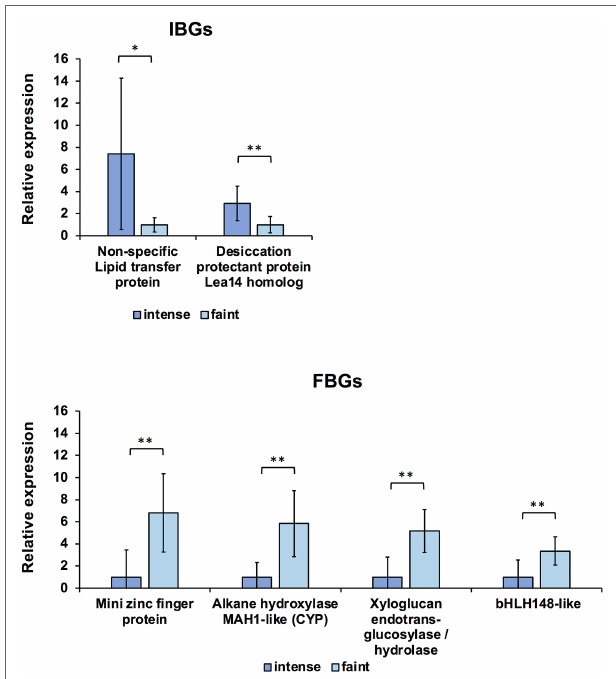
FIGURE 4 | Quantitative RT-PCR (qRT-PCR) analysis of candidate intense- blue genes (IBGs) and faint-blue genes (FBGs) in petal stage 4 of intense- and faint-blue F 2 individuals. Expression of each gene was normalised using GtUBQ as the internal control. Error bars indicate means ± SDs. * Shows statistical significance (Welch’s t -test at ** p < 0.01, * p <